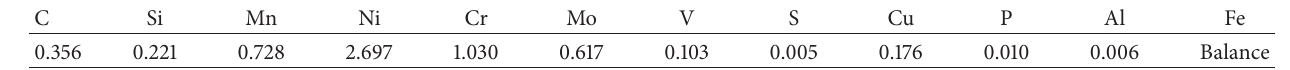
Table 1: Chemical composition for high strength steel